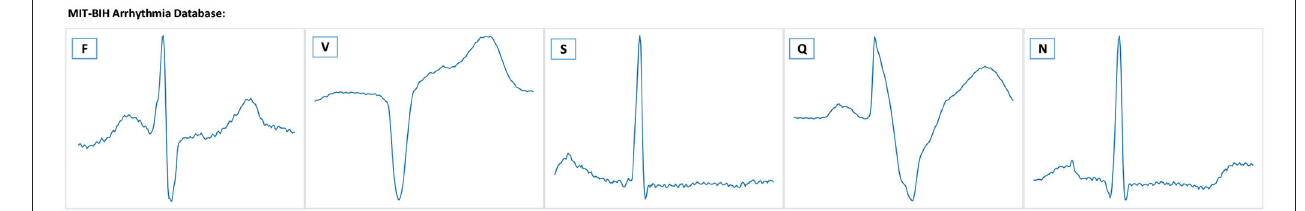
FIGURE 7 | Example ECG signals from the MIT-BIH database. There are five heartbeat classes named N, S, V, F, and Q. The meaning of each letter is shown in Table 4 .